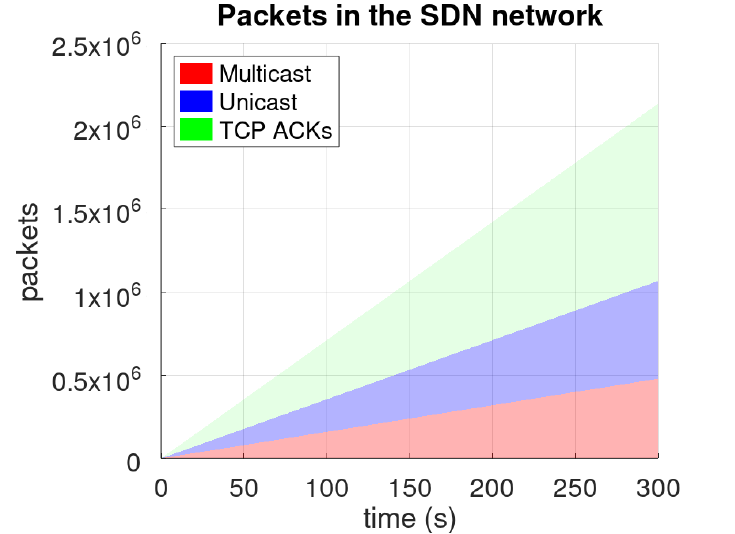
Figure 15. Example of packets retransmitted within the SDN